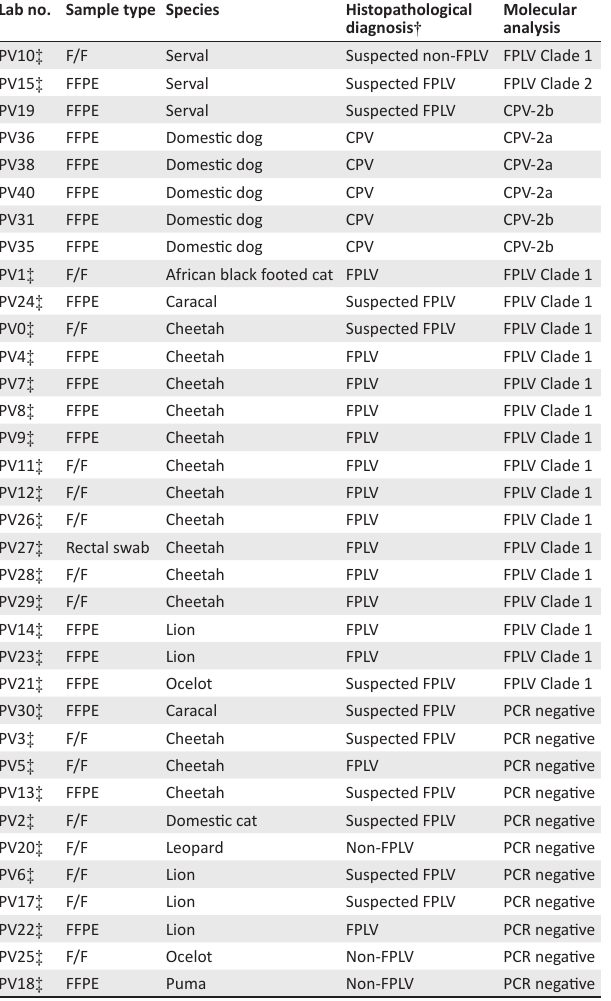
TABLE 1: Sample type, species, histopathological diagnosis and molecular analysis of parvoviral samples collected as part of the National Zoological Garden, South African National Biodiversity Institute wildlife disease database.